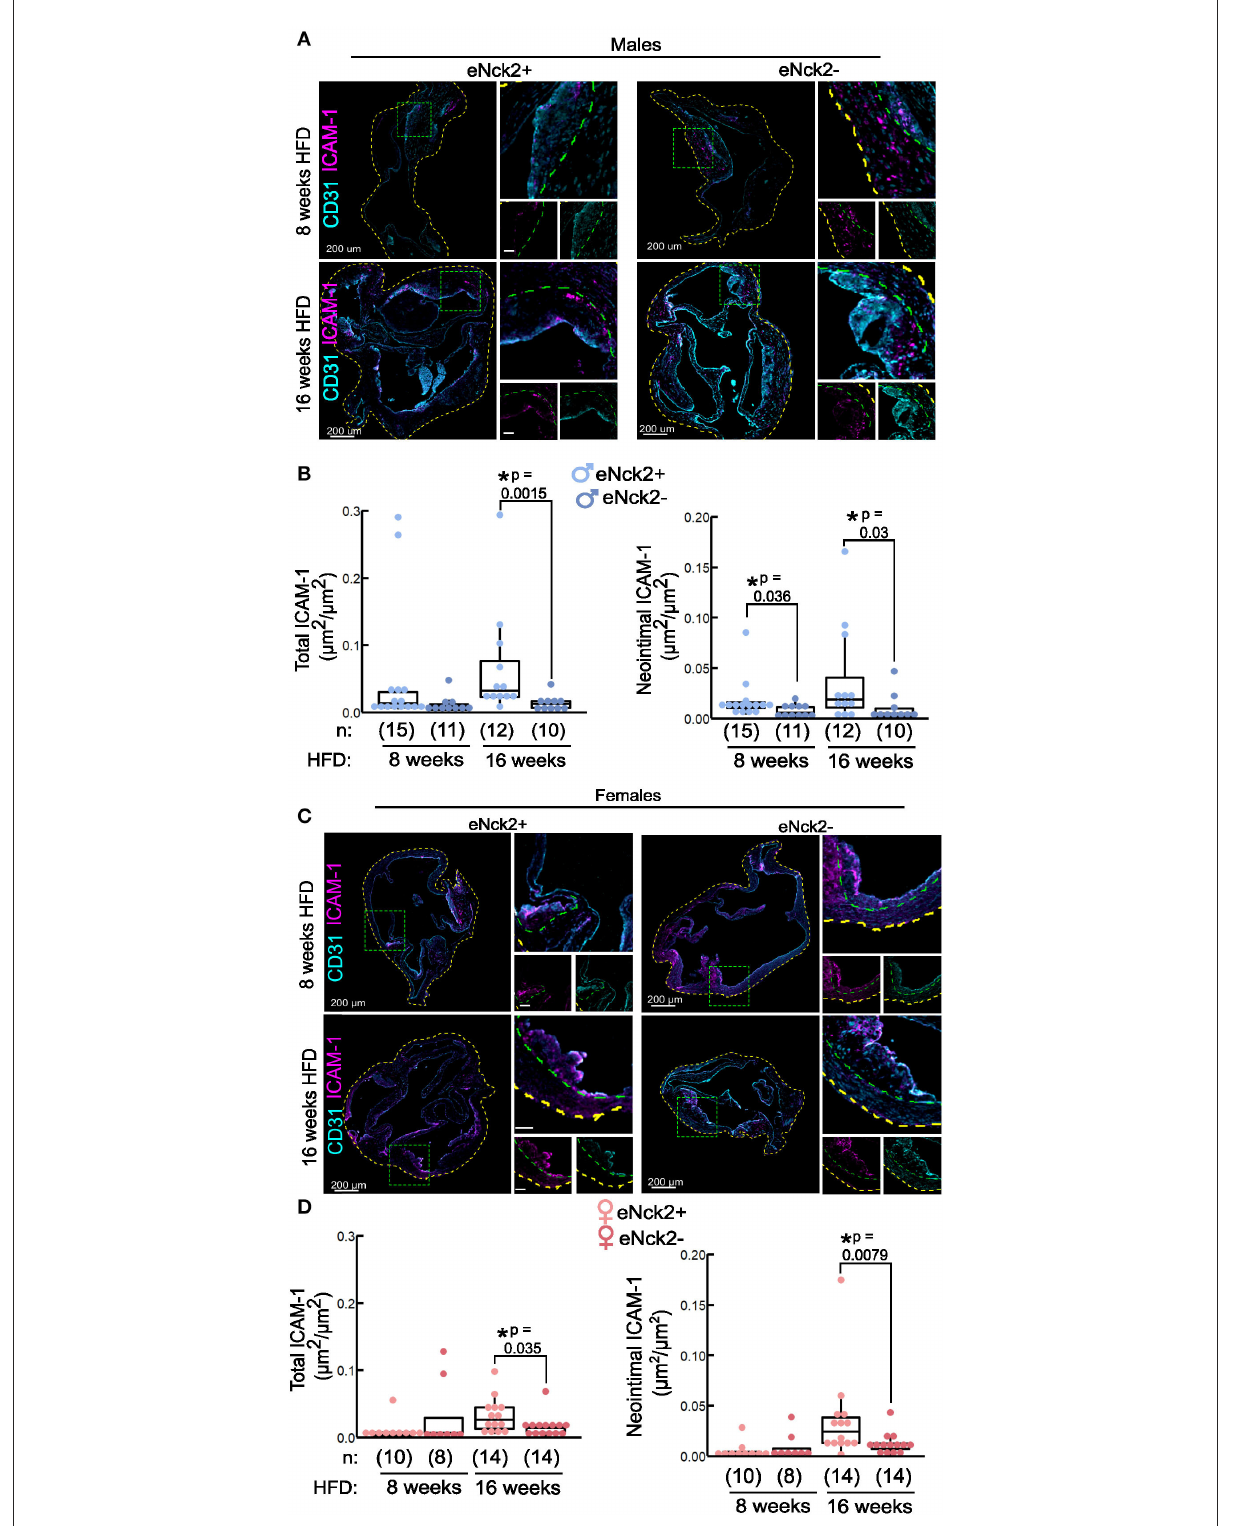
FIGURE3 Determination of ICAM-1 in aortic roots of atheroprone mice with and without endothelial-specific deletion of NCK2. Animals were fed a HFD for 8 or 16 weeks to assess atherosclerotic lesion initiation and progression, respectively. (A,C) Representative confocal images of aortic